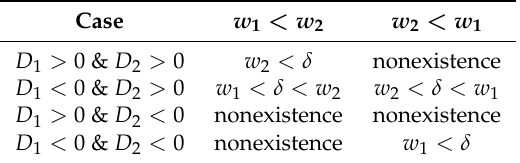
Table 2. Existence condition of E + when r 1 > r 2 .